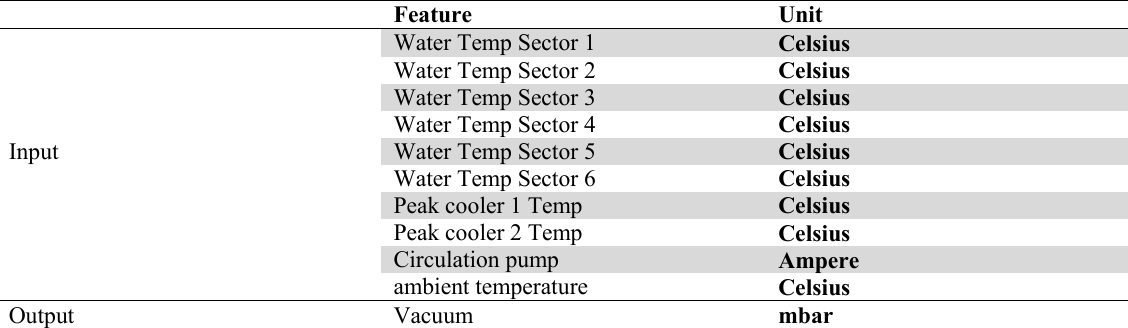
Main Cooling System data structure